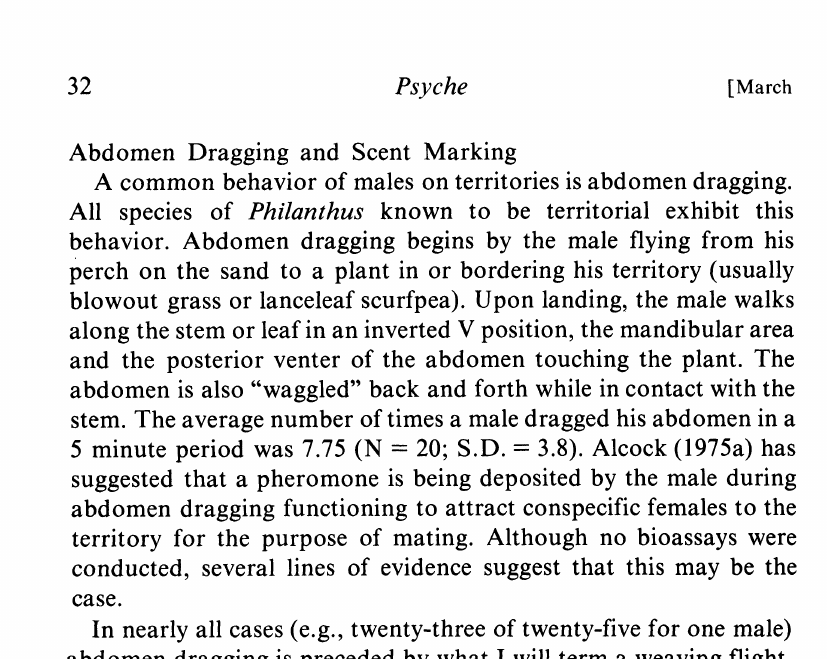
A common behavior of males on territories is abdomen